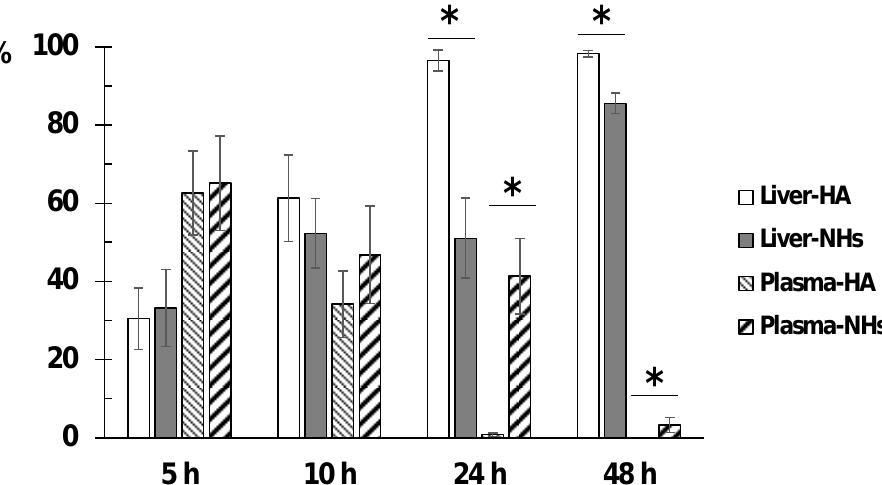
Figure 6. Comparison of the evolution of the percentage of accumulation of HA and NHs in liver and plasma. * indicates tatistically significant differences.